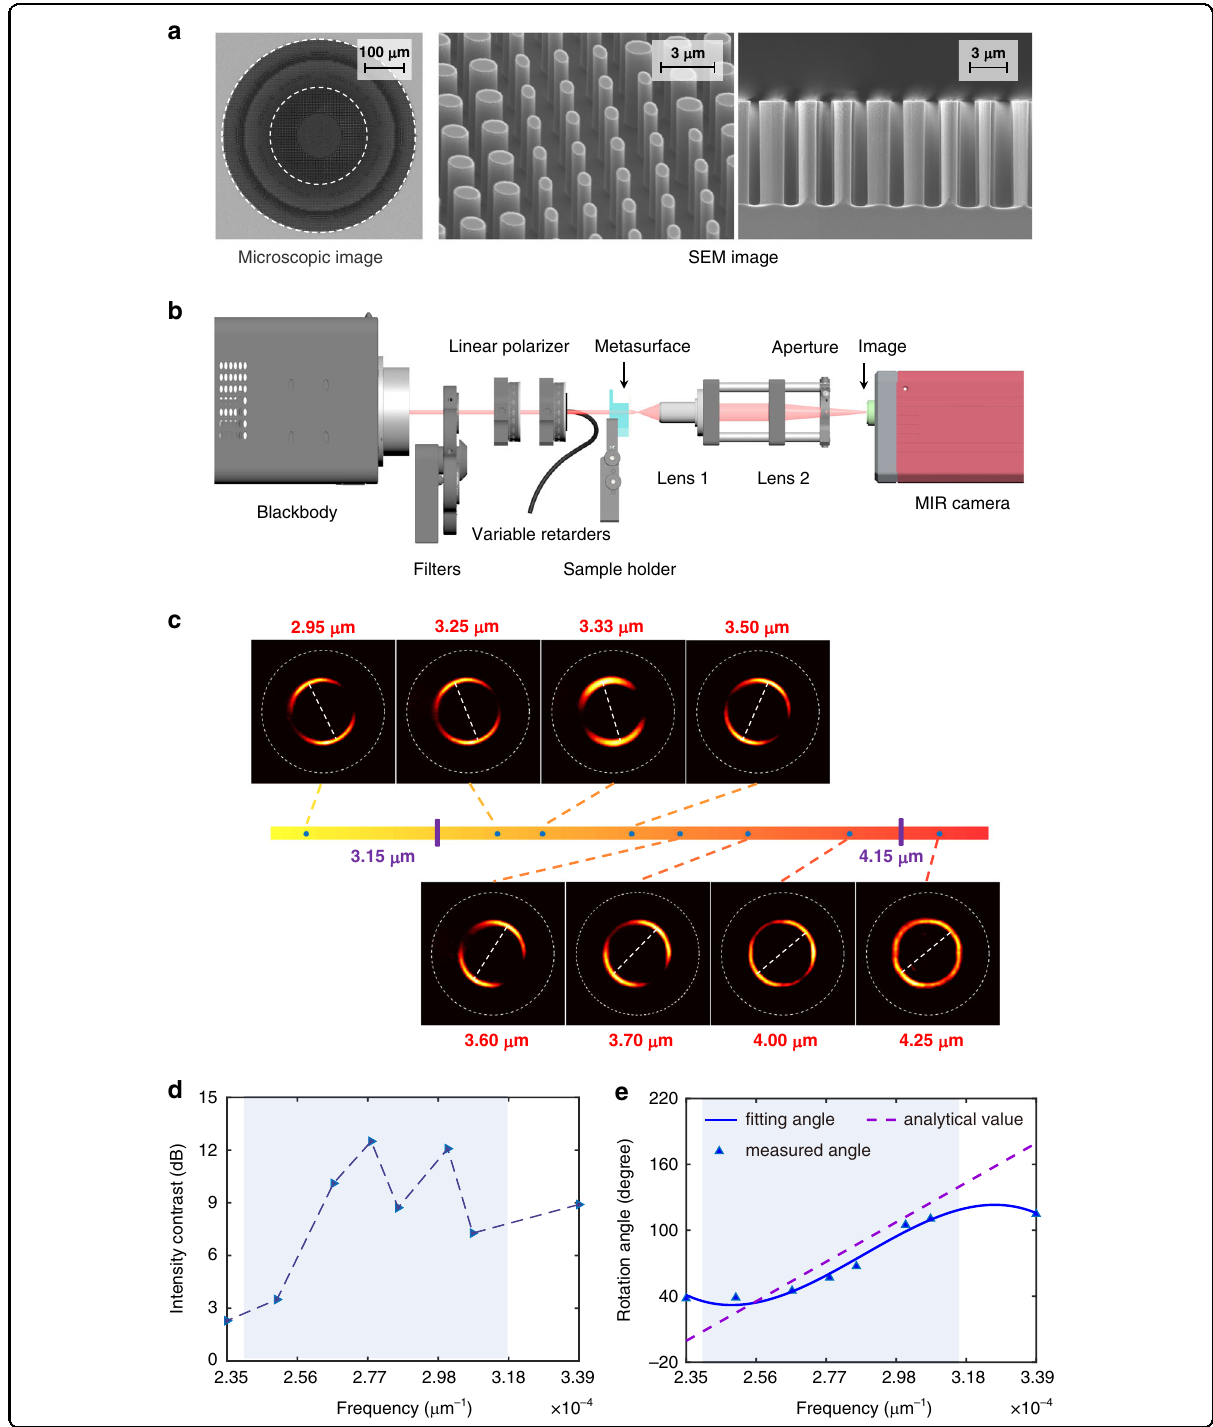
one denotes the right circular polarization state. The inner radius is 75 μ m and outer radius is 200 μ m. The focal length is 350 μ m. The excellent performances are further con fi rmed in Fig. 4b by extracting the intensity contrast from Fig. 4a. All the measured contrasts within